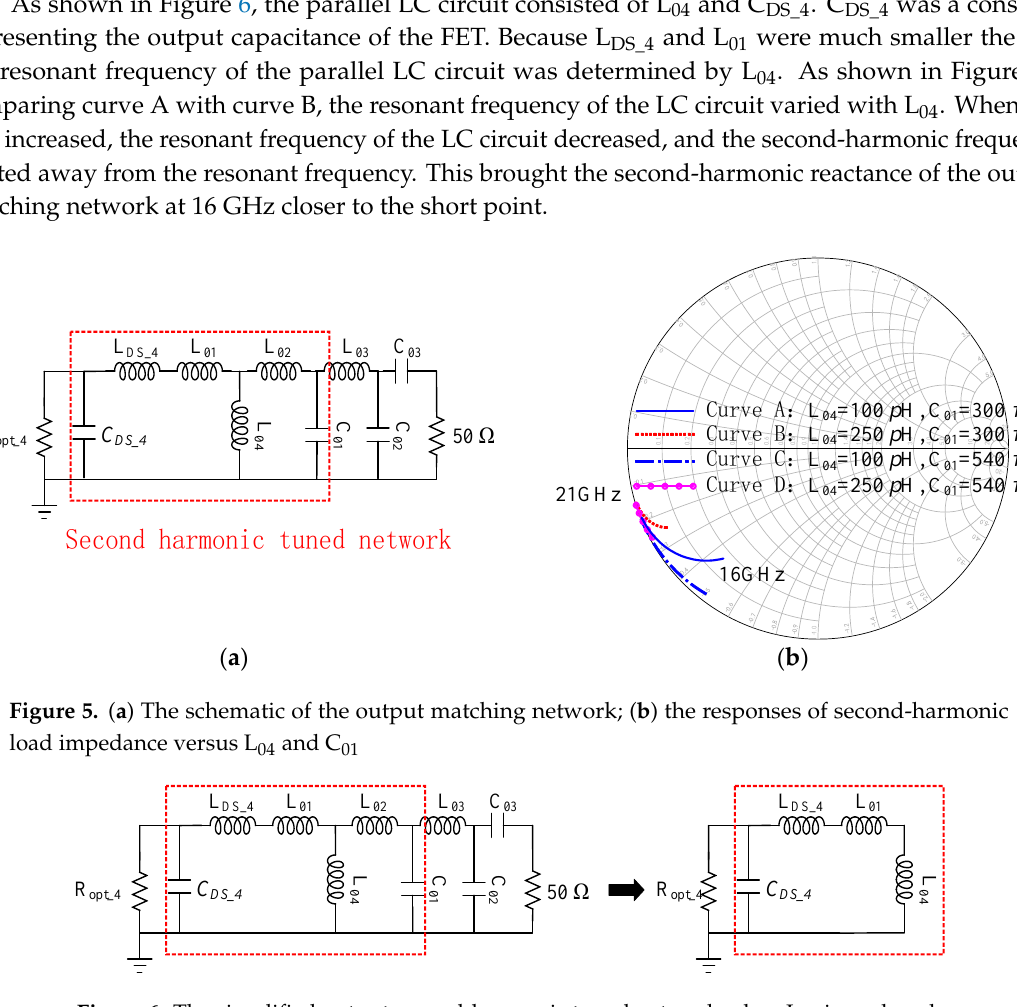
Figure 4. The schematic of the presented high-efficiency power amplifier.